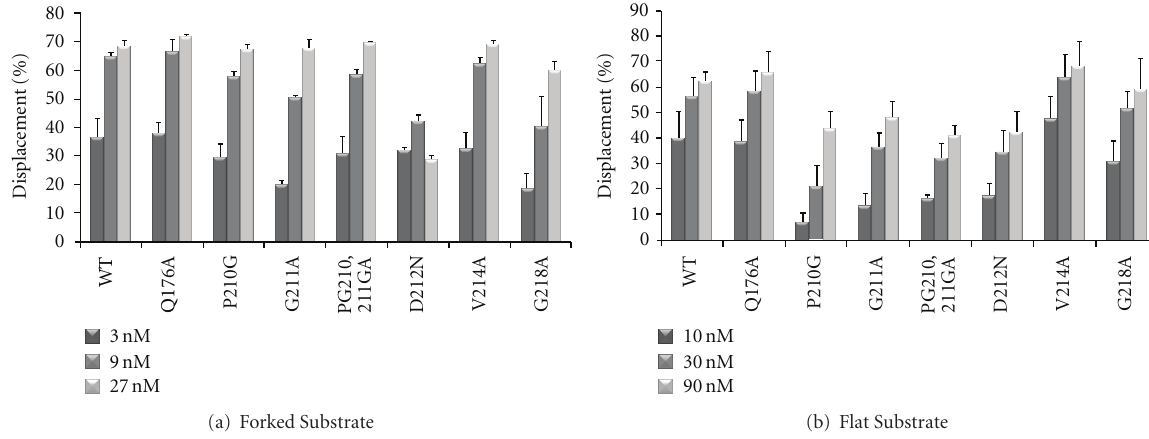
Figure 3: Helicase activity by the mutant MCM proteins. Helicase assays of wild-type and mutant MCM proteins were performed as described in “Section 2” with 10fmol of forked (a) or flat (b) DNA substrates. In (a) the protein concentrations used were 3, 9 and 27nM (as monomer) while in (b) they were 10, 30, and 90nM (as monomer). The average results of three independent experiments with standard deviations are